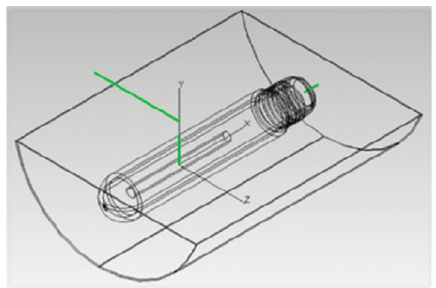
Figure 9: The model of the new counterbeam light.